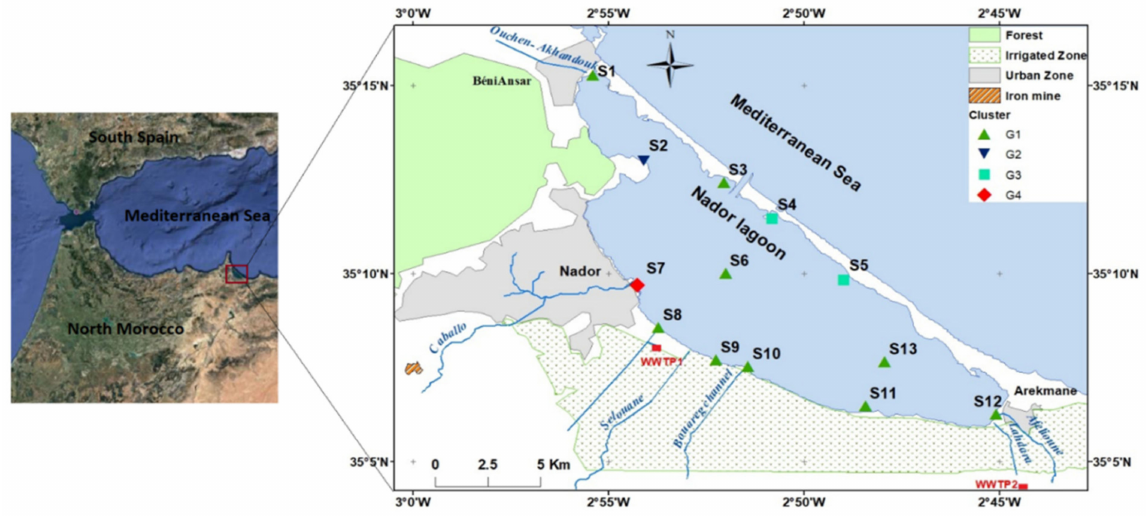
Figure 1. Map of Marchica Lagoon (S, sample station; G, group